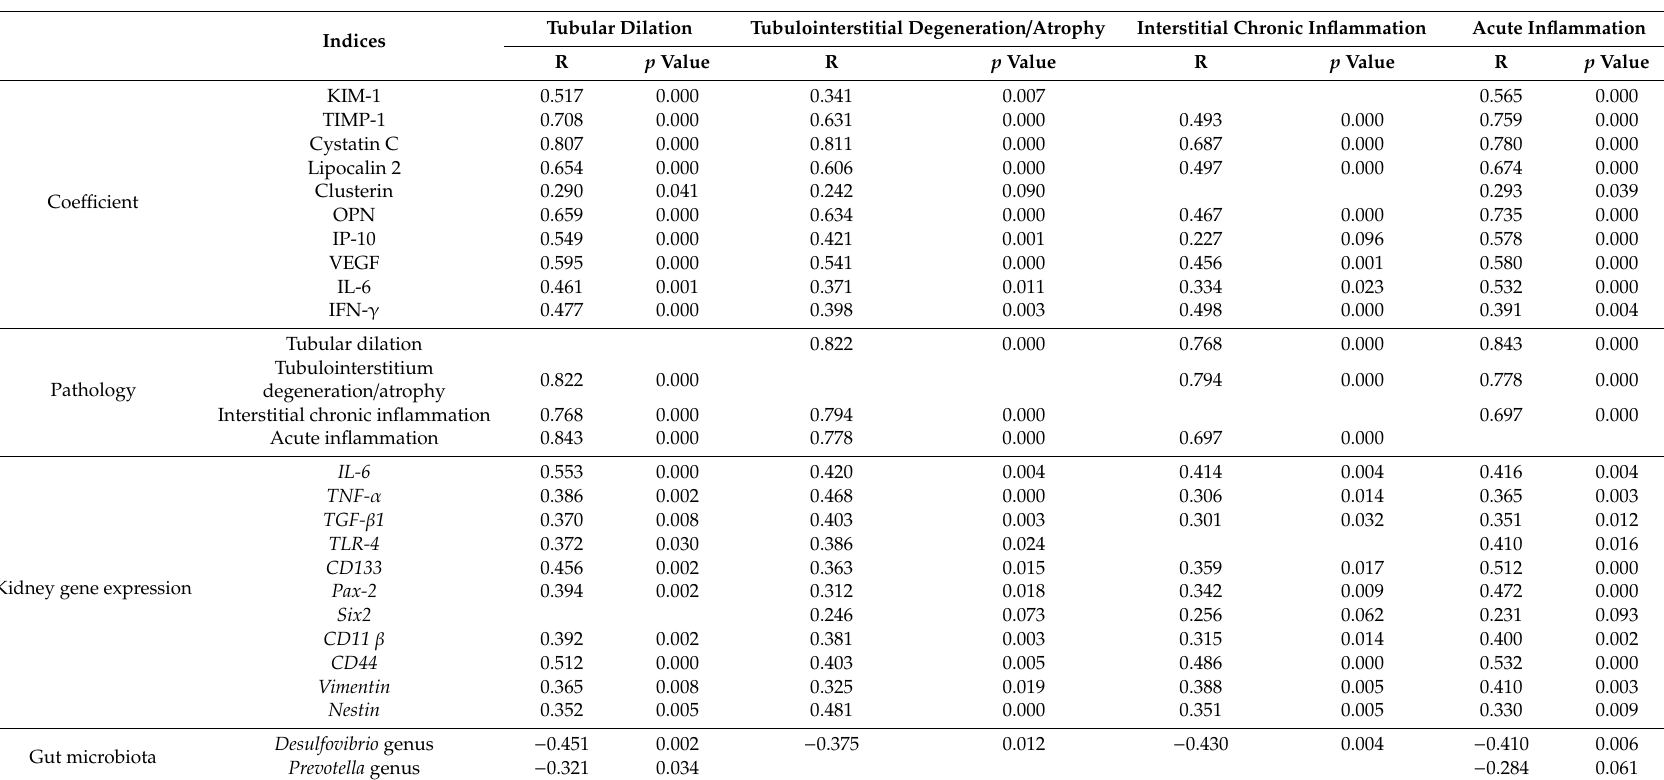
Table 3. Significant correlation coe ffi cients between histopathology and hemodynamic parameters, and kidney and gut microbiota gene expression *. KIM, kidney injury molecule; TIMP, tissue inhibitor of metalloproteinases; VEGF, vascular endothelial growth factor; OPN, osteopontin; IFN, interferon; IP, inducible